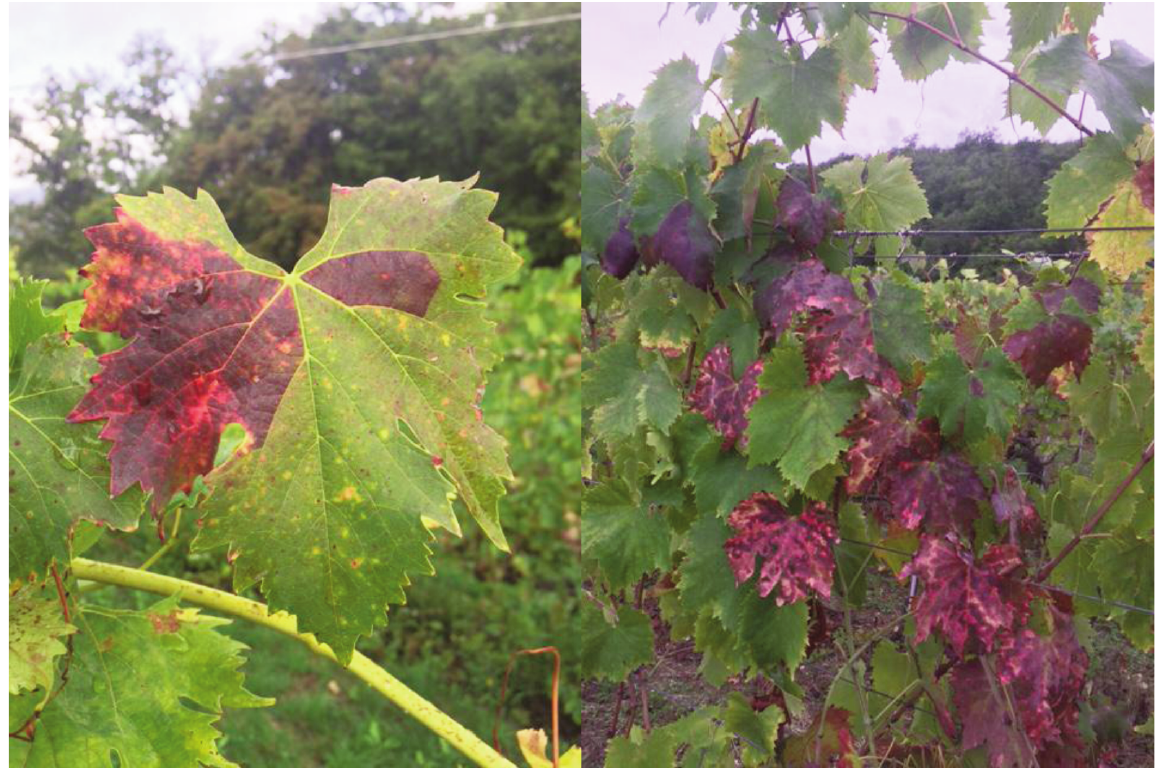
Fig. 4 - Symptoms of GY on cv.